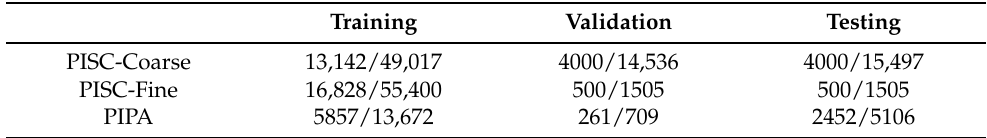
Table 1. Numbers of images and social relation samples. For example, 16,142/49,017 means 16,142 im- ages with 49,017 social relation